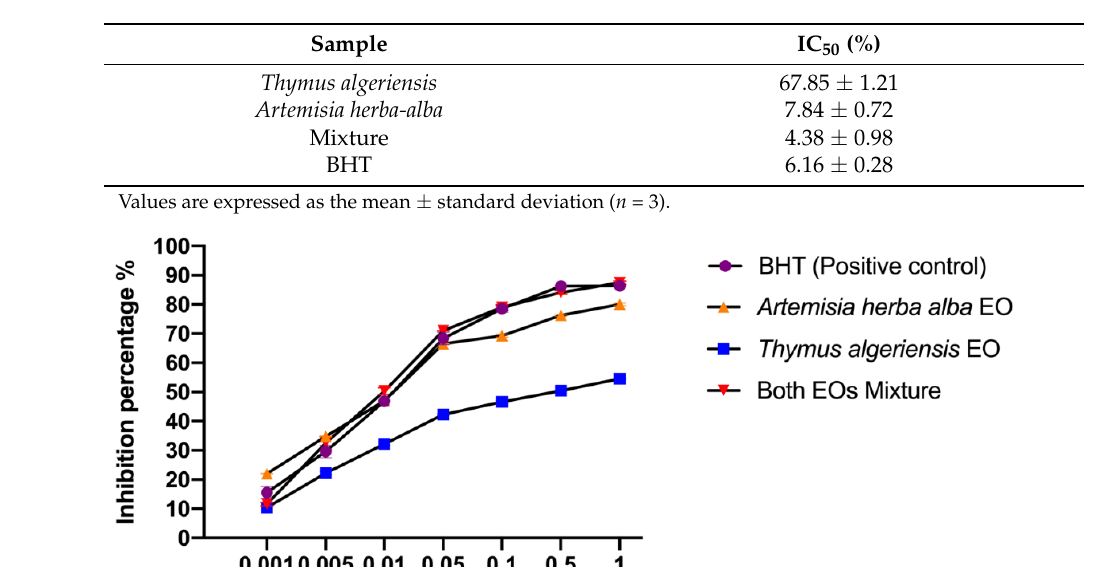
Table 2. The concentrations of the essential oils of Thymus algeriensis , Artemisia herba-alba , their mixture (50:50), and butylhydroxytoluene (BHT) that inhibit 50% of antioxidant activity (IC 50 ) in the DPPH test.